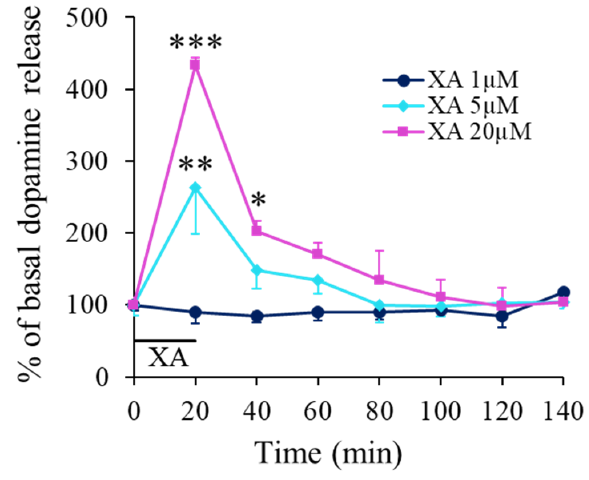
Figure 2. XA-induced DA release in the prefrontal cortex. A. Time evolution of DA release measured by microdialysis. Filled symbols represent the mean percentage (±SEM) of the mean basal DA release (mean of 8 × 20 min dialysate fractions before retro-dialysis of XA) measured in consecutive 20 min cumulated dialysate. Continuous lines are interpolation between data points. The black bar indicates the period of XA application at concentration of 1, 5 or 20 µM as indicated. The dopamine basal release level (100%) was 433 ± 32 fmol/20 min for the 20 µM-treated group ( n = 3 to 5 rats per group). Under the influence of XA administered directly to the brain tissue, we observed a graduated increase in the extracellular dopamine with a local four-fold increase by reference to controls for a concentration of XA of 20 µM. The local diffusion of XA into the brain through the probe was estimated in vitro around 18%. * p < 0.05; ** p < 0.01; *** p < 0.001, comparison with control before XA infusion. Not corrected from in vitro recovery.